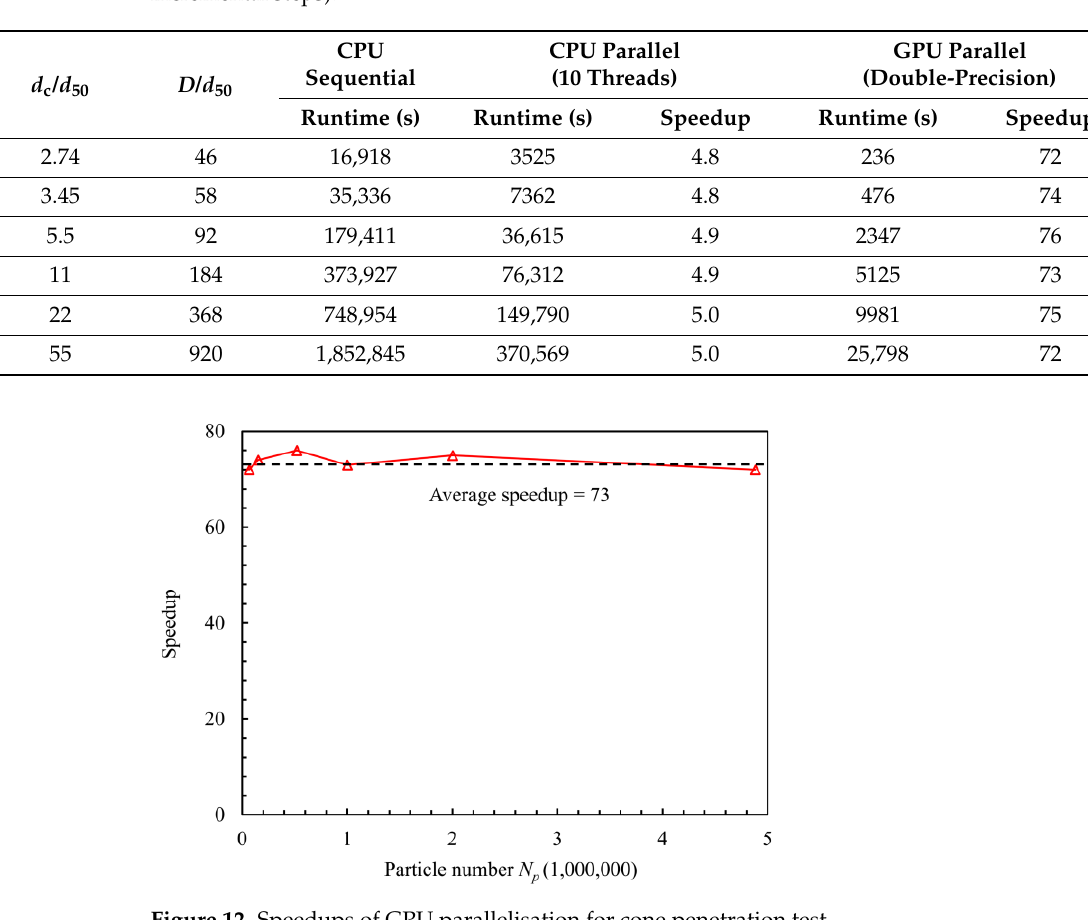
Figure 13. Runout profiles of sand grains due to dam break.